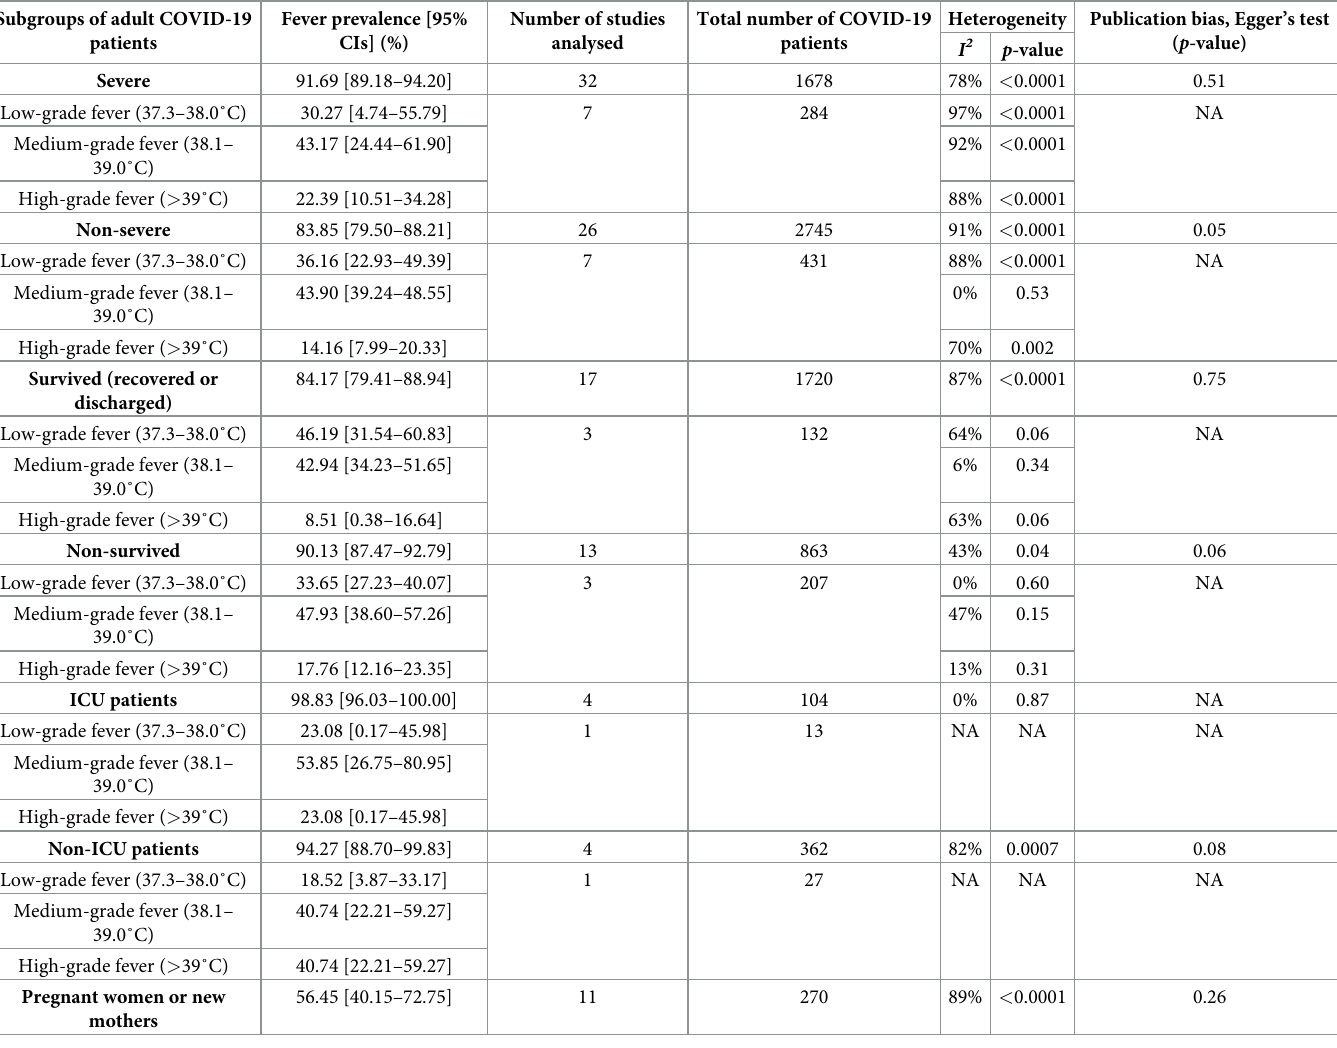
Table 2. Pooled prevalence and characteristics of fever in different subgroups of COVID-19 patients.